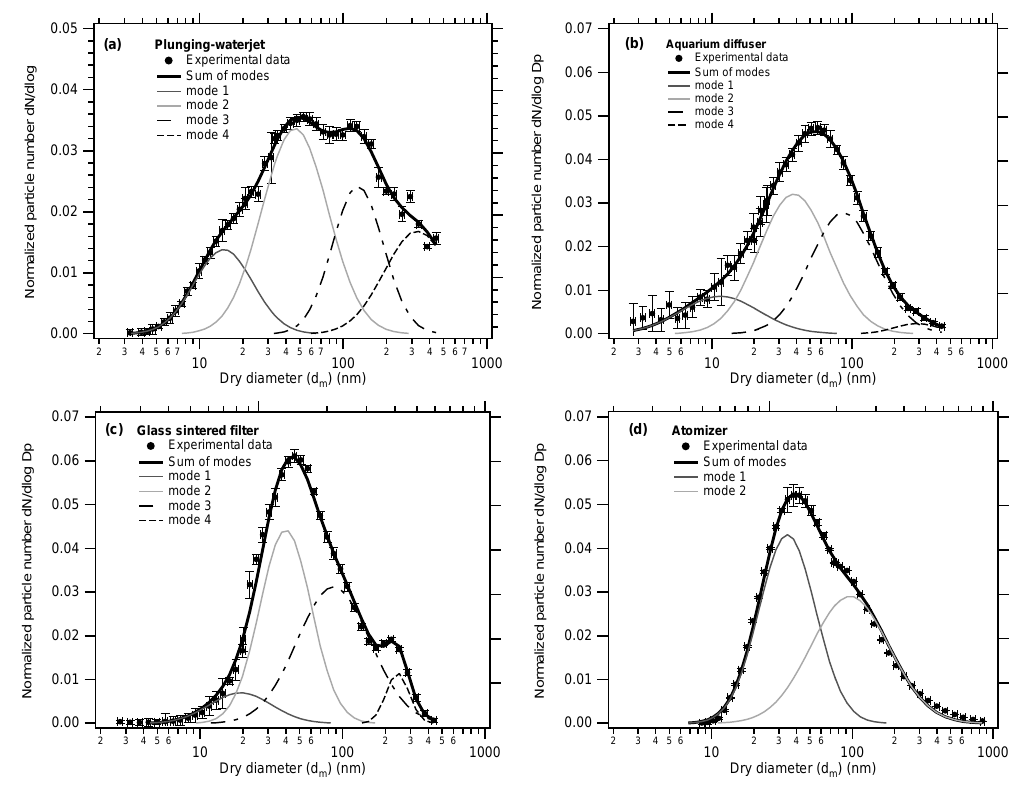
Fig. 6. Normalized particle size distributions of aerosols generated from artificial seawater by (a) the plunging-water jet system (8 water jets), (b) aquarium diffuser (8lpm air flow), (c) glass sintered filter (5lpm air flow) and (d) atomizer. A shape factor χ =1.04 was applied to the presented data. Horizontal error bars indicate the uncertainty in the diameter selected by the DMA as function of the shape factor correction in the range from spherical ( χ =1) to cubic ( χ =1.08) shape. Vertical bars indicate the variability of the measurements obtained from 6 scans during 1h period as ± 1 σ standard deviation. Table 3. Characteristics of aerosol size distributions obtained from artificial seawater samples in this study in comparison with atmospheric marine aerosol measurements (Sellegri et al., 2006) (D pg , geometric mean diameter (shape factor χ = 1 . 04 for laboratory measurements); σ g , geometric standard deviation; N/N t (%), lognormal mode particle number to total number ratio).